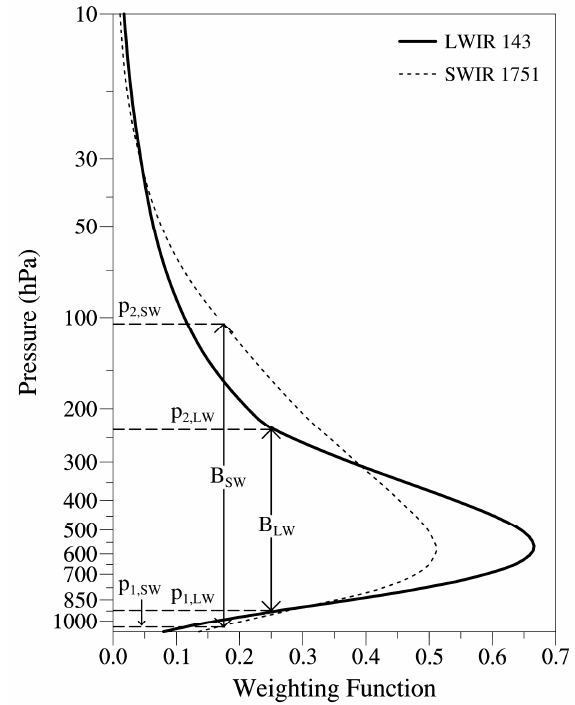
Figure 4. The WF broadness B LW = p 1, LW − p 2, LW and B SW = p 1, SW − p 2, SW for LWIR channel 143 (solid curve) and SWIR channel 1751 (dashed curve). The di ff erence of WF broadness ∆ B = | B LW − B SW | between LWIR channel 143 and SWIR channels 2023, 1715 and 1751, whose WFs are shown in Figure 3, is 86, 227 and 255 hPa, respectively.